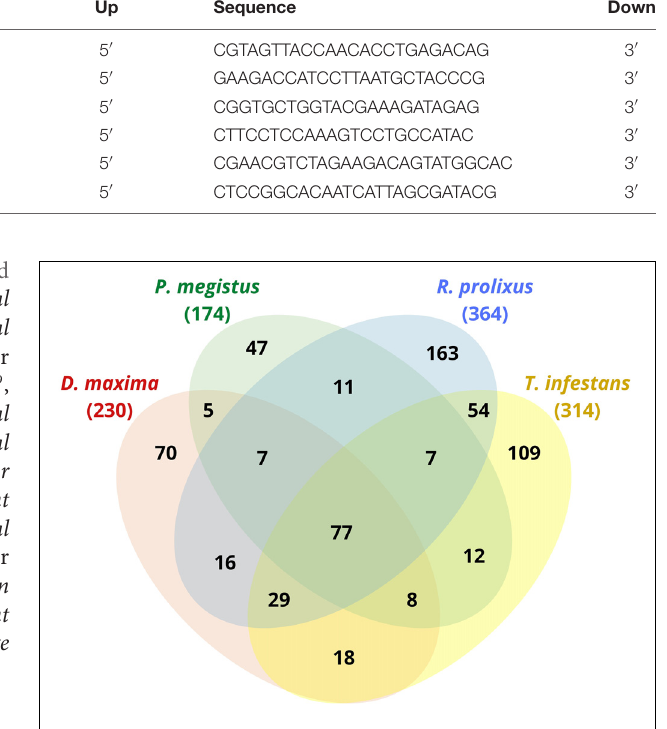
FIGURE 1 | Venn diagram of proteins found in the digestive tract of D. maxima , P. megistus , R. prolixus, and T.